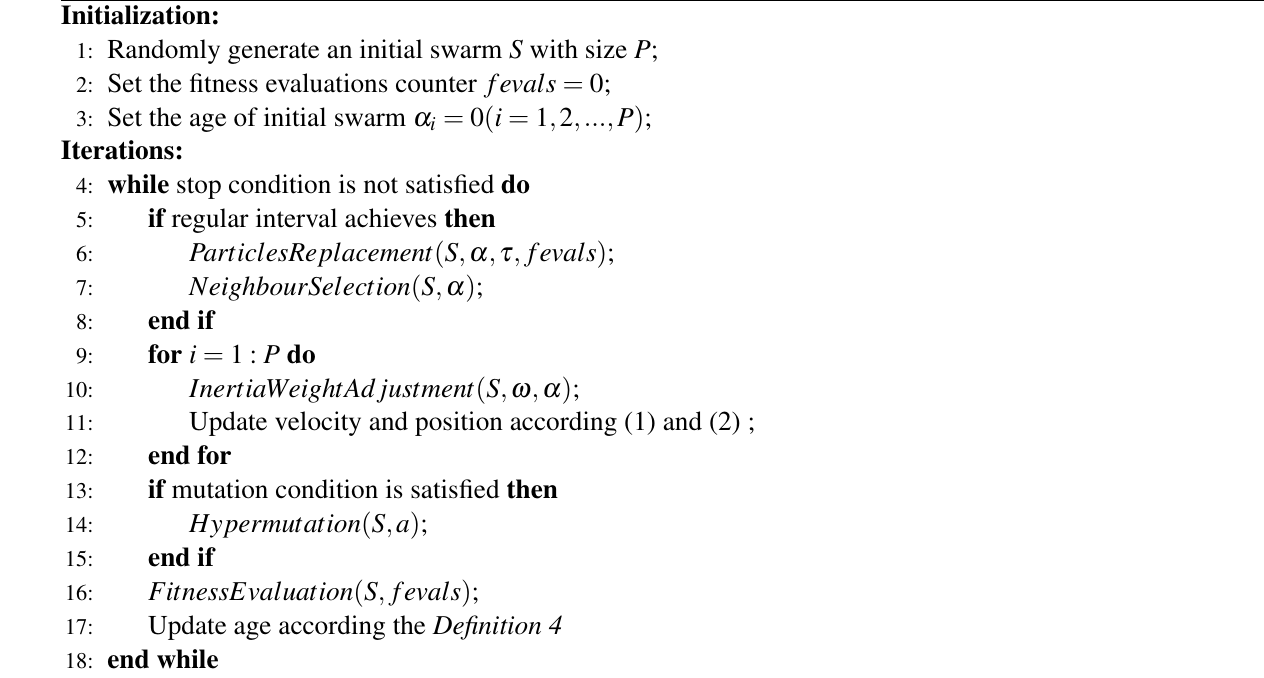
Algorithm 1 The framework of the proposed